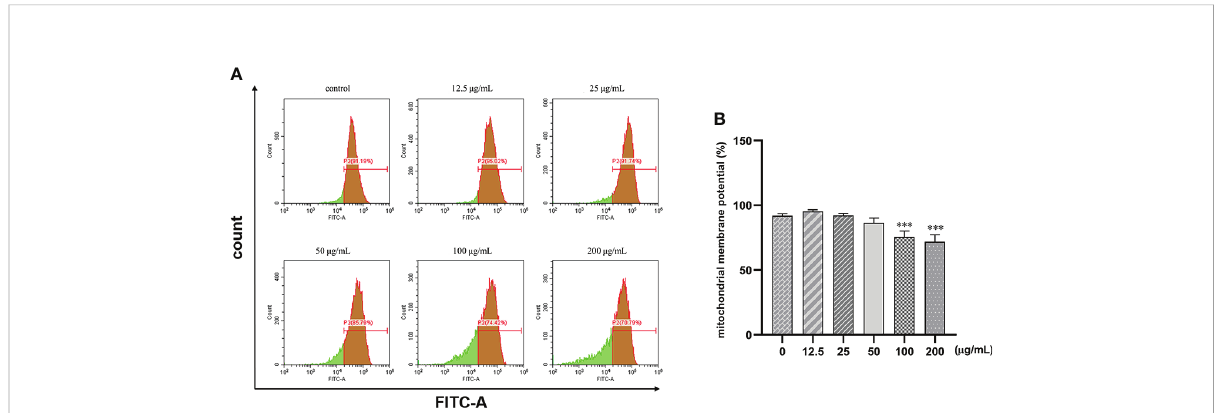
FIGURE 8 Effects of 1,2,3,4,6-pentagalloyl- b -D-glucose on mitochondrial membrane potential in SGC7901 cells. SGC7901 cells were incubated with different concentrations of 1,2,3,4,6-pentagalloyl- b -D-glucose for 48 (h) Dy m was evaluated using JC-1 in treated cells. (A) Dy m after treatment of cells with 0, 12.5, 50, 100, and 200 m g/ml of b -PGG. (B) Average mitochondrial membrane potential rate of SGC7901 cells. *** p < 0.001 vs. 0 µg/ml.